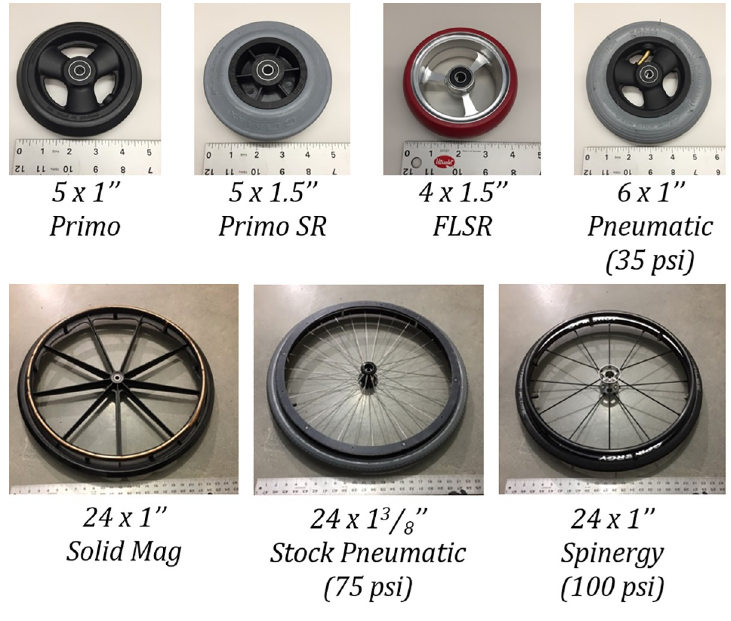
Fig 5. Tested components. Array of components representing a range from standard, off-the-shelf wheelchair configurations to costlier up-charged versions.